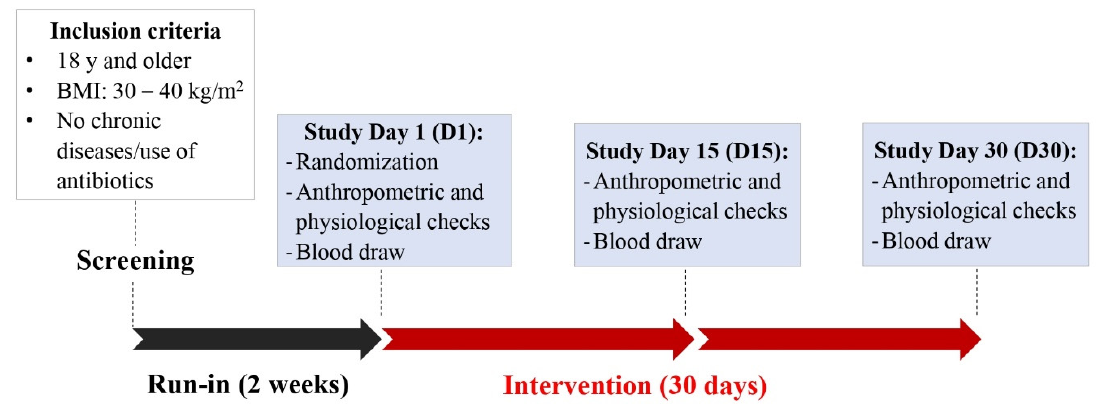
Figure 1. Graphical representation of study protocol.